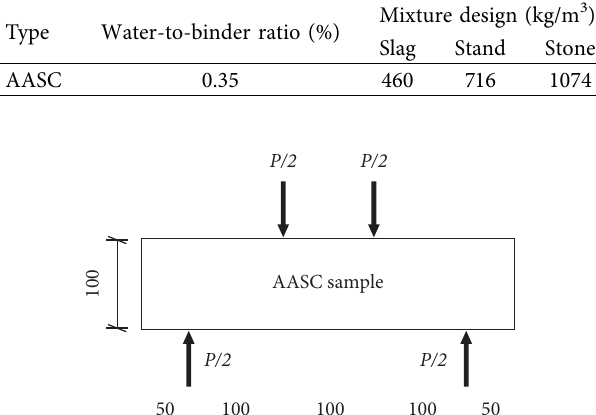
Table 2: The mix proportion of AASC.